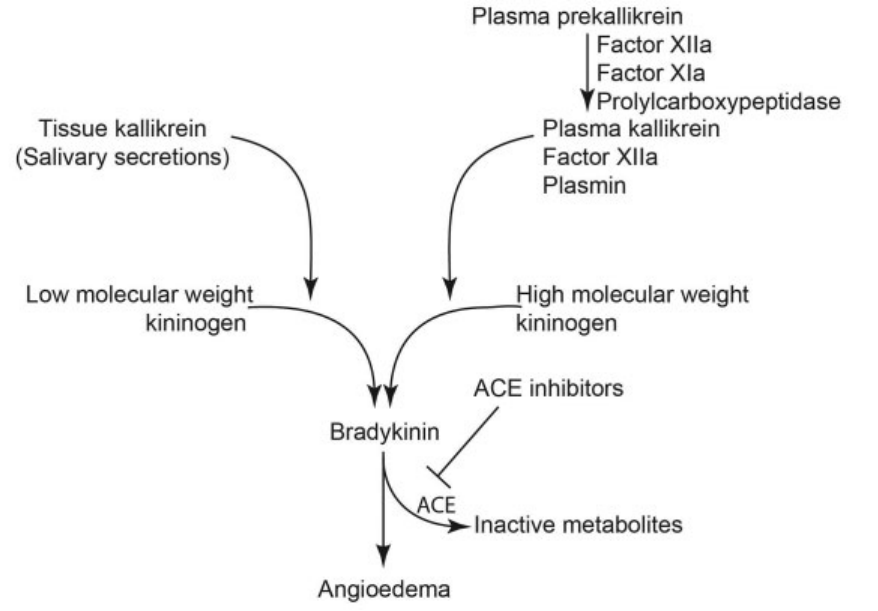
Fig. 2. The kallikrein proteolytic cascade. The preferred substrate for plasma kallikrein is high molecular weight kininogen while tissue kallikreins metabolize low and high molecular weight